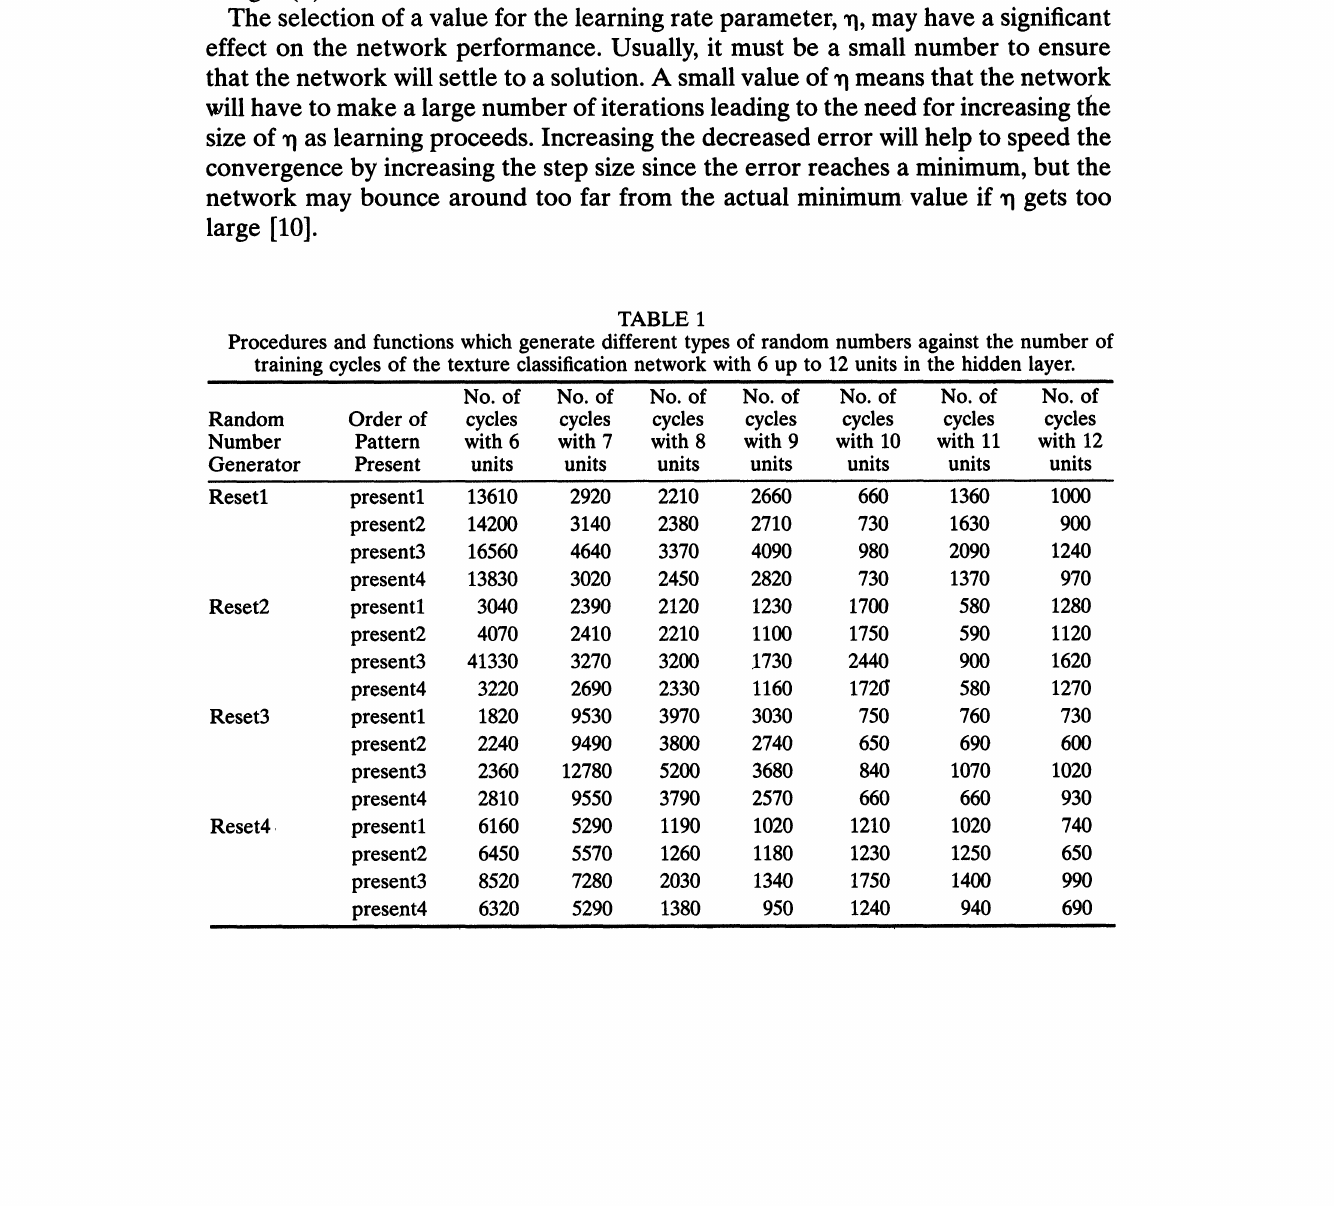
TABLE 1 Procedures and functions which generate different types of random numbers against the number of training cycles of the texture classification network with 6 up to 12 units in the hidden